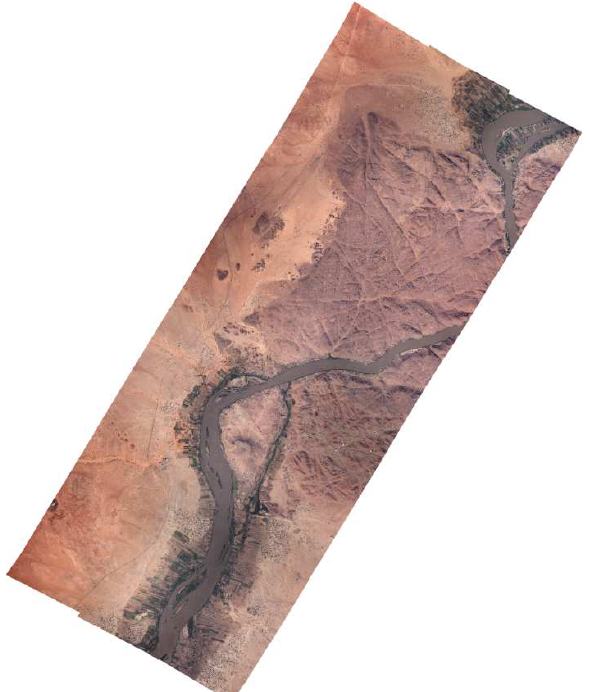
Figure 3: Orthophoto-mosaic of the Wad al Basal area Orthophoto and a core DTM were the final products that delivered a robust and good result.